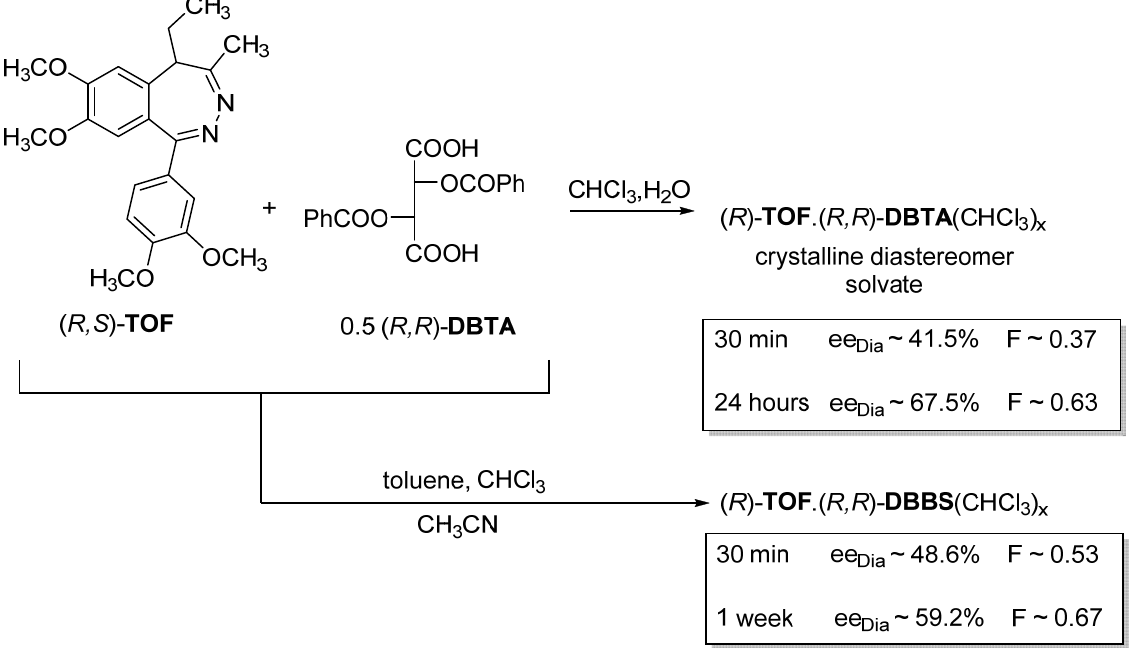
Figure 11. At the separation of racemic tofisopam ( TOF ) the formation of the microcrystalline dia- stereomer does not occur without a solvate-forming solvent. diastereomer does not occur without a solvate-forming